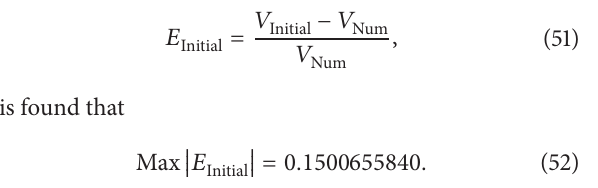
and numerical solution 𝑉 Initial